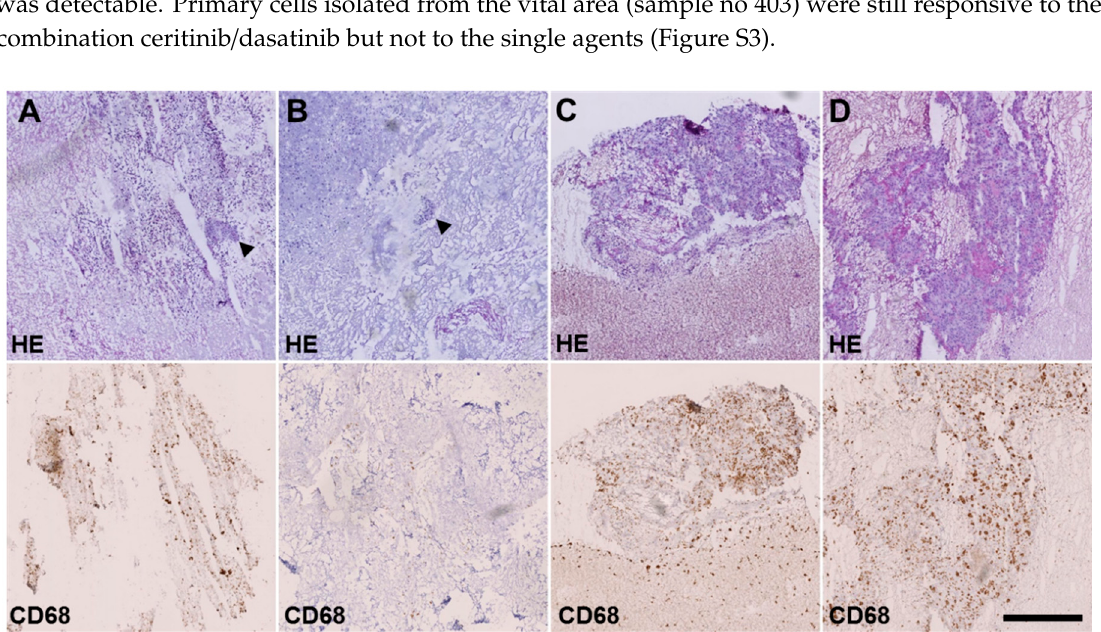
Figure 3. Necrosis and macrophage infiltration after treatment with certinib / dasatinib. Frozen sections from four di ff erent pleural sites stained with hematoxylin and eosin (HE, upper row) and CD68 immunohistochemistry (lower row). Conventional histology unveiled extensive necrosis, inflammatory cell infiltration and scattered small tumor cell groups (arrowheads) in samples 1 ( A ) and 2 ( B ). In contrast, vital tumor cell content was increased in sample 3 ( C ) and particularly in sample 4 ( D ). Scale bar: 500 µm.